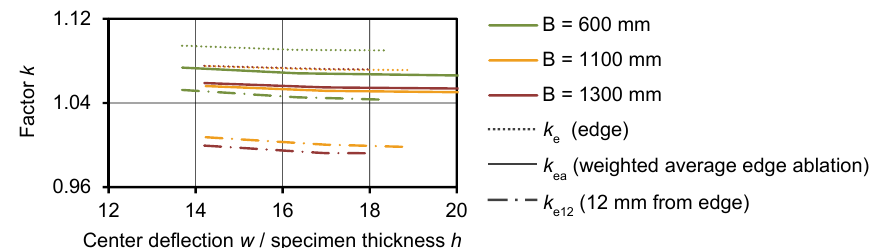
Fig. 9 Maximum and minimum level of the bending stress in the area of edge ablation and weighed average factor k ea for the effective bending strength. With β = 9.8 for B = 600 mm, β = 18.5 for B = 1100 mm and β = 63.7 for B = 1300 mm.